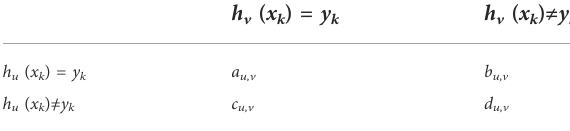
TABLE 1 Joint distribution for the two base classi fi